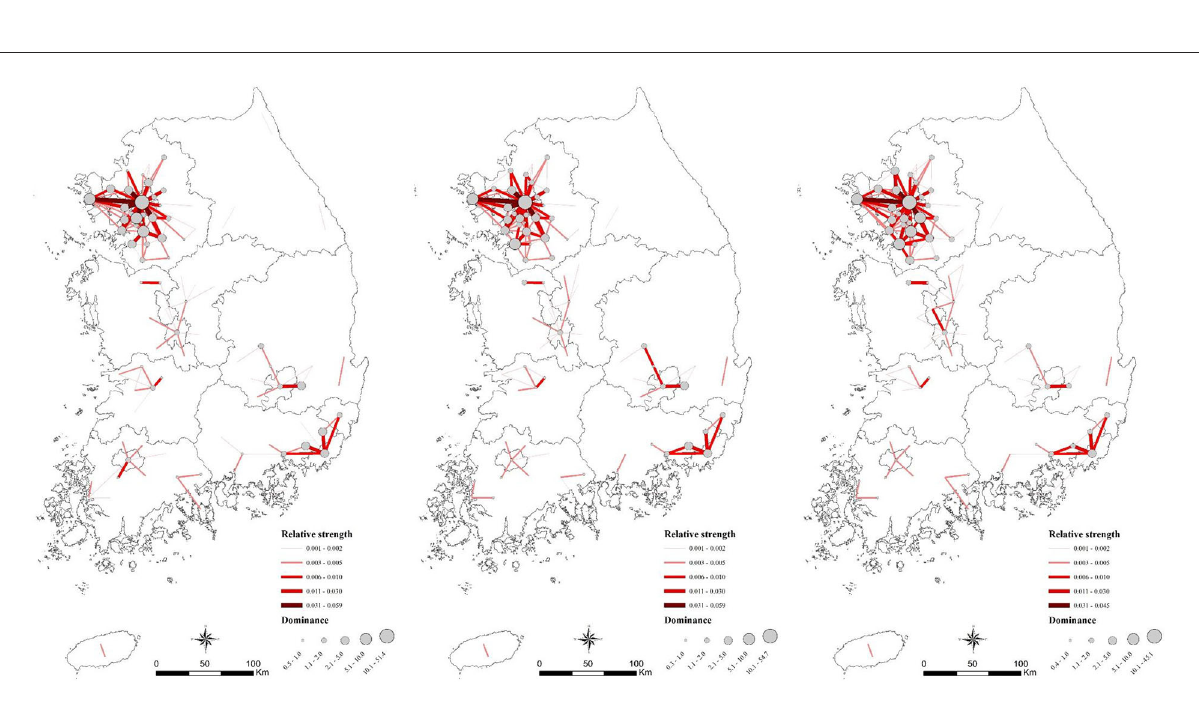
FIGURE4 Relative strength and Dominance (2000, 2010, 2020). Note that only links where the sum of RSI of in- and outflow is ≥ 0.001; Only nodes with DII ≥ 0.5.